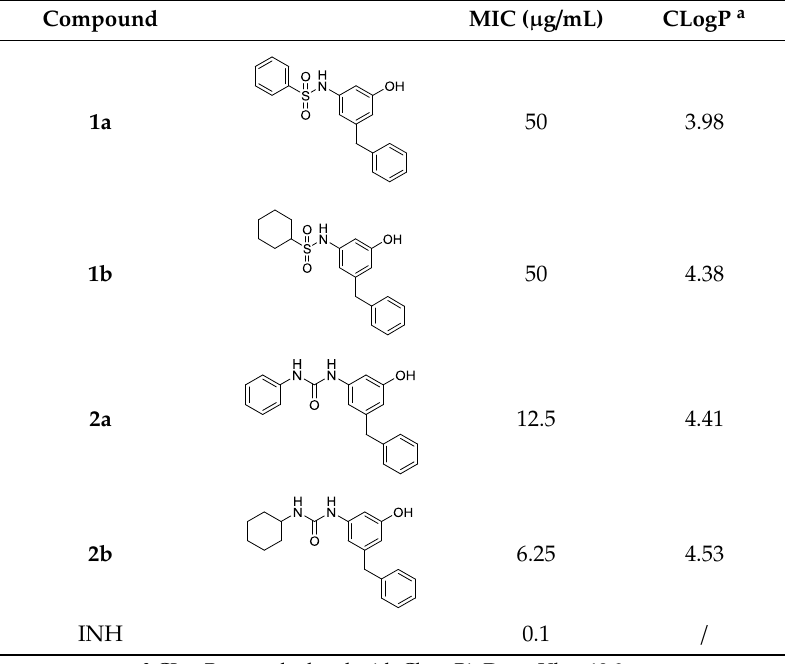
Table 2. Inhibitory activity of 3a – 3p against Mtb H37Ra.